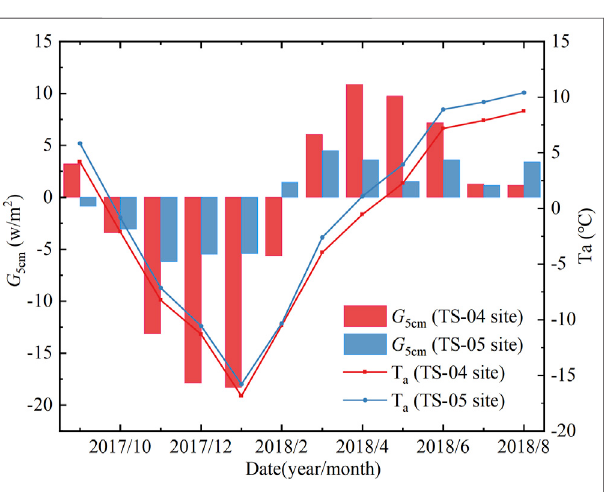
Frontiers in Earth Science |